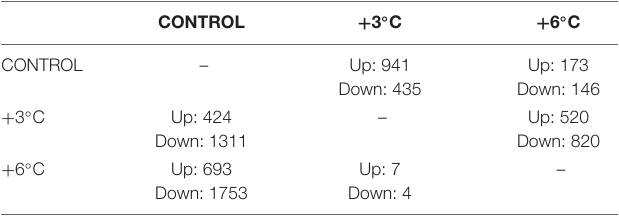
TABLE 1 | Number of significantly differentially expressed genes (DEGs) in juvenile pinfish ( p -adj < 0.05).